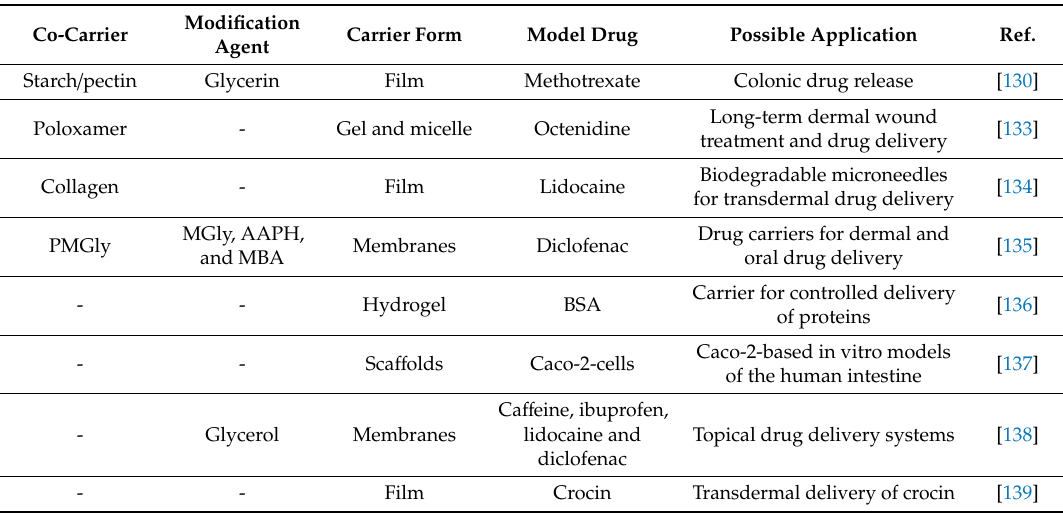
Table 3. Diverse BNC-based delivery systems with specific modification agents, carrier forms, model drugs, and potential